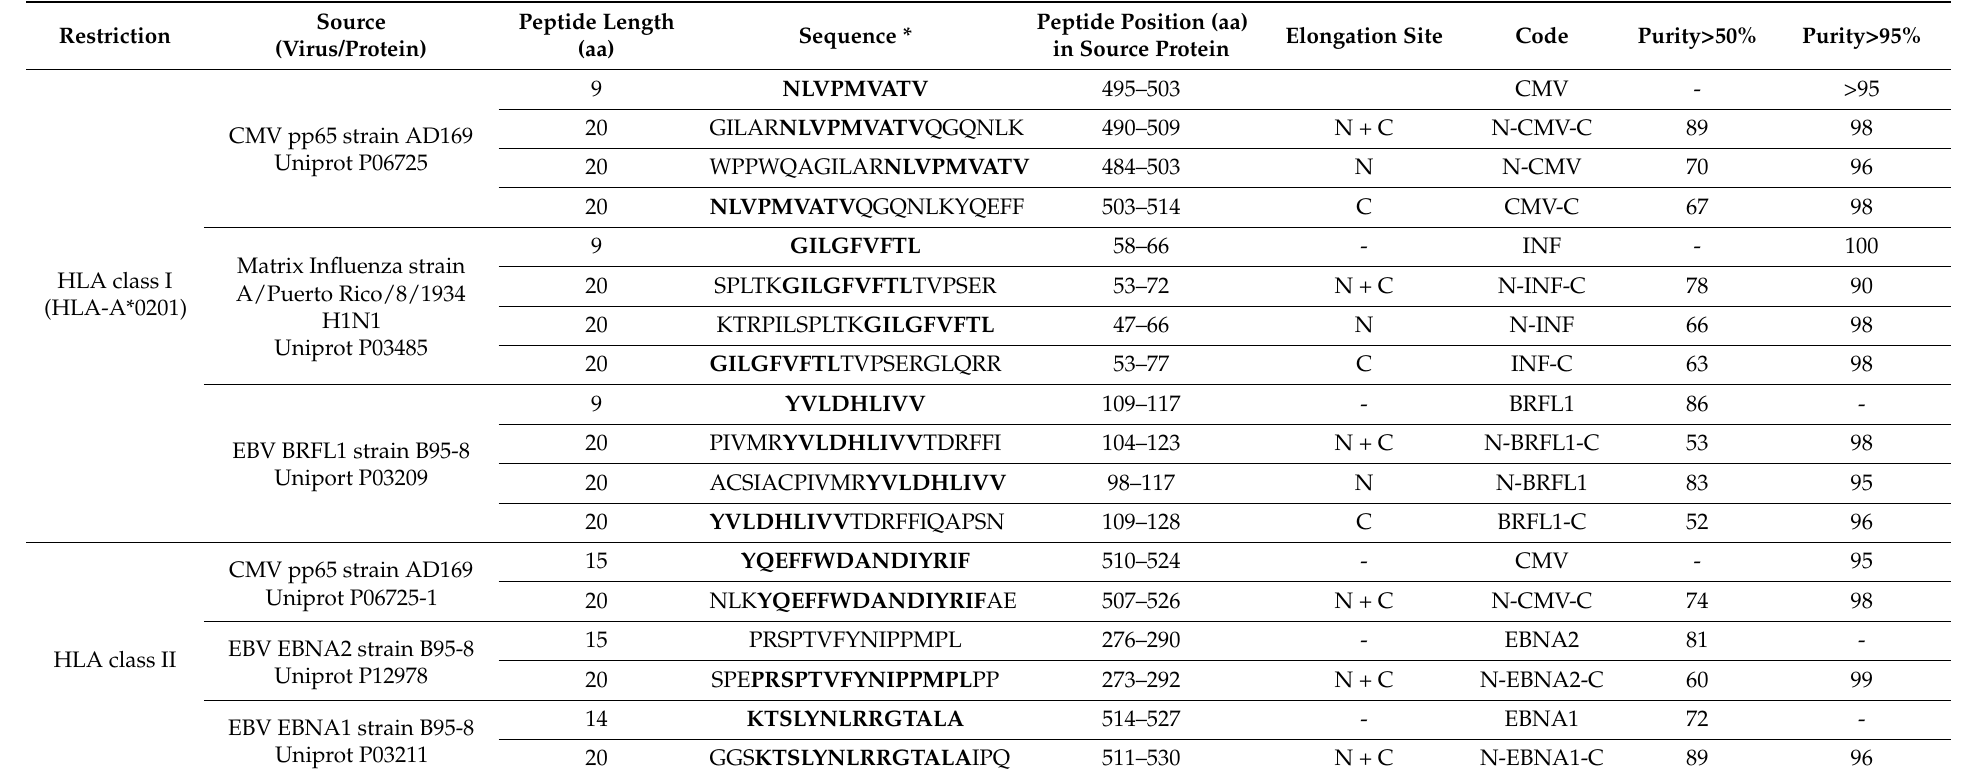
Table 1. Virus-derived synthetic peptides used in the